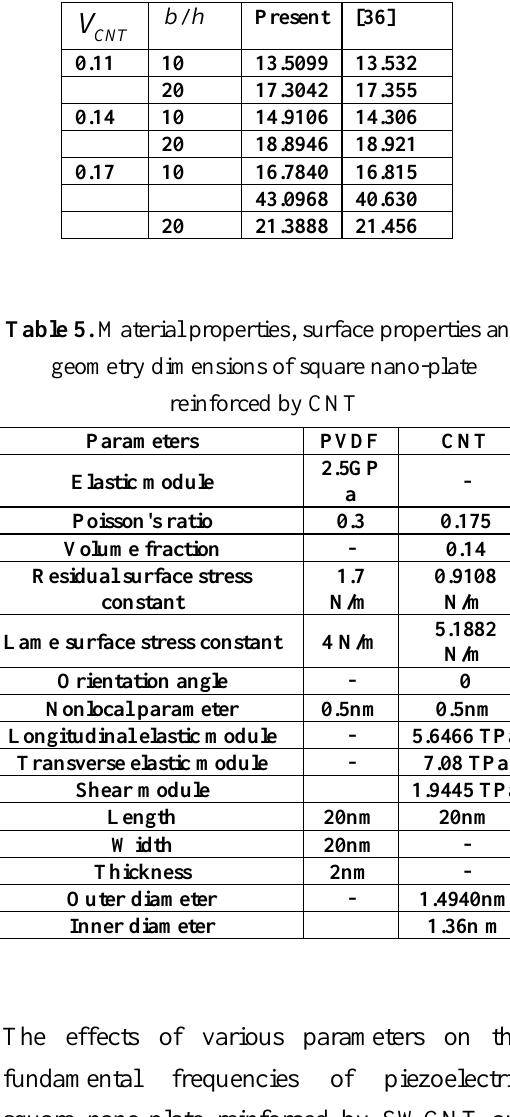
b   of piezoelectric Fig. 1. / nonlocal local nanocomposite plate against CNT orientation angle for various nonlocal parameter values a- CPT b- FSDT Fig. 2 depicts the effect of elastic foundation  for FSDT and parameters on / nonlocal local CPT. As it can be seen for both theories increases with the presence